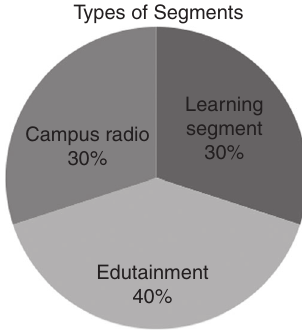
Figure 2. Types of segments on iRadio OUM